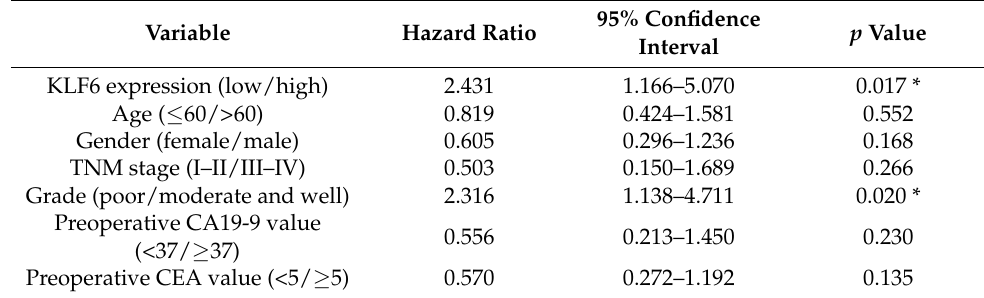
Table 2. Univariate Cox proportional hazards analysis for survival of PAAD